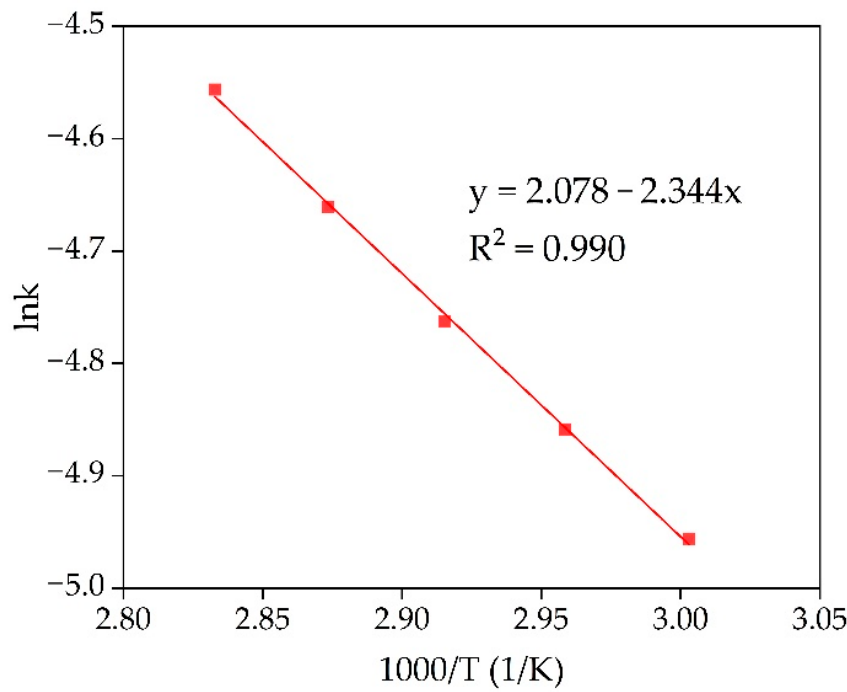
Figure 7. Dependence of lnK on 1000/T (Arrhenius plot) for Sc extraction from RMF in temperature range from 60 °C to 80 °C.